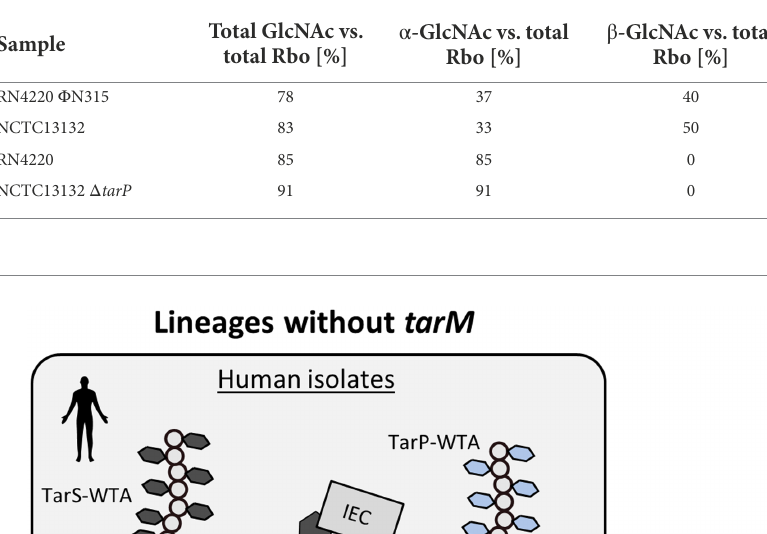
TABLE 2 Relative abundance of NMR motifs for analyzed tarM-encoding tarP phage lysogens (lab-made RN4220 Φ N315 and native NCTC13132) and the corresponding strains without tarP locus (RN4420 and NCTC13132 Δ tarP